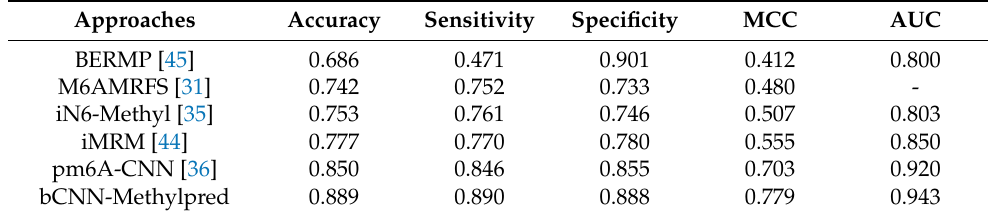
Table 9. Comparison of m6A site prediction using proposed and state-of-the-art approaches based on S. cerevisiae